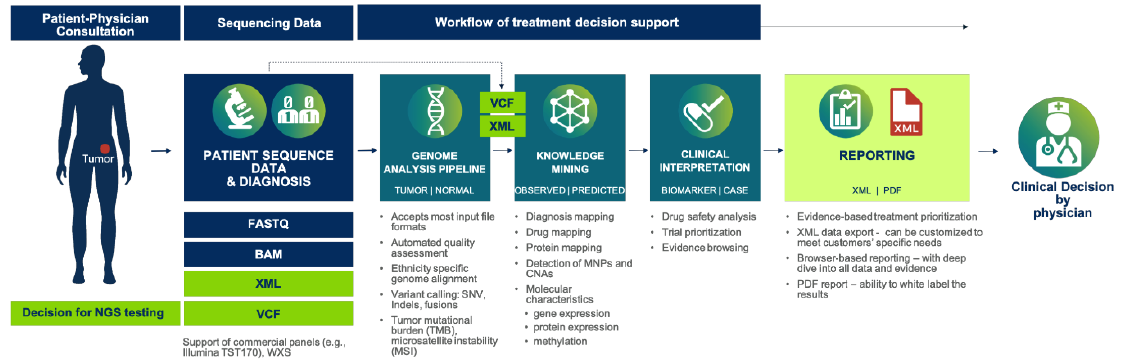
Figure 3. Showing the end-to-end process of genome-guided treatment decision support. After DNA sequencing of the tumor biopsy, sequence data is input to a computational system that identifies and interprets the clinical implications of genomic variants. A diagnostic report is then automatically generated and provided to the treating oncologist for review.